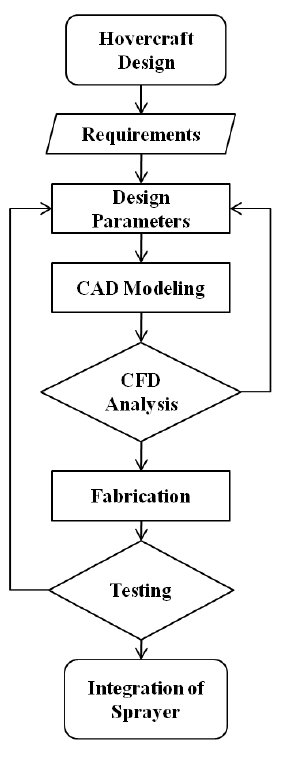
Figure 2. Hovercraft design